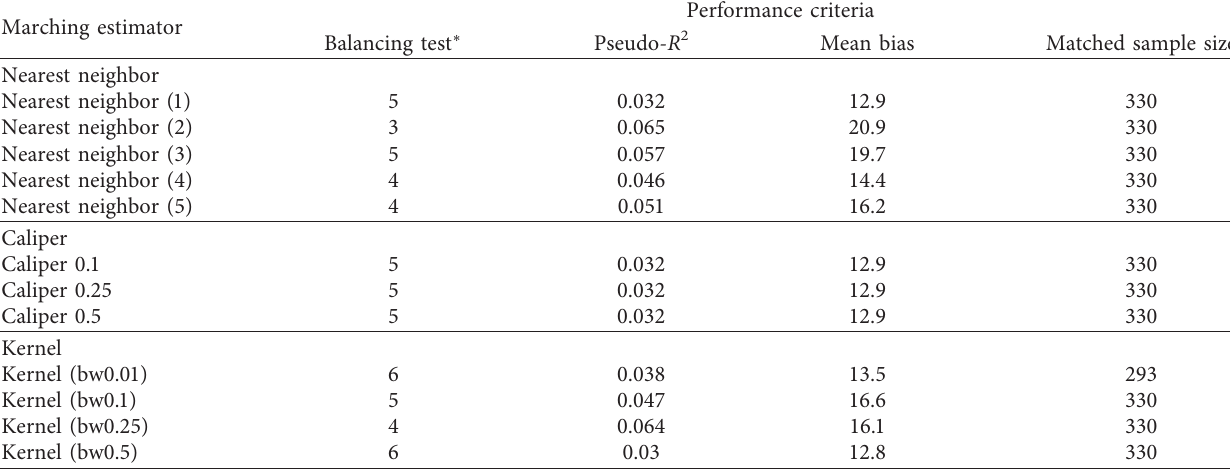
Table 9: Performance of different algorithms.